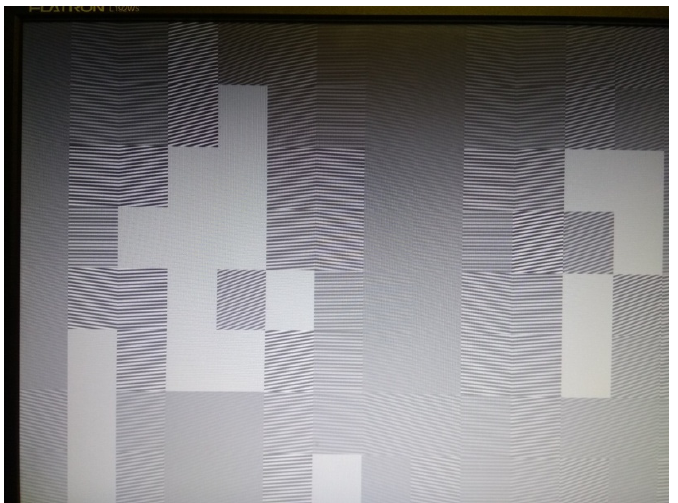
Figure 7. The structure of one of the cells of a hologram (holopixel), calculated according to Figure 5b.